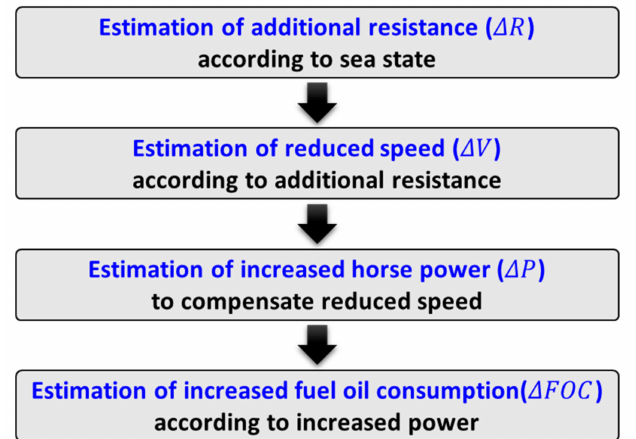
Figure 2. Process of estimation of fuel oil consumption using ISO